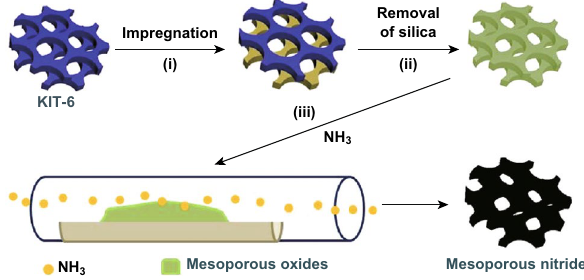
Fig. 1 Schematic illustration of the synthesis strategy for ordered mesoporous bimetal Ni 3 FeN through a nanocasting